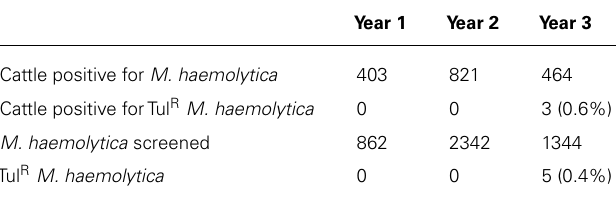
Table 4 | Number of cattle and M. haemolytica analyzed by year of the study a .